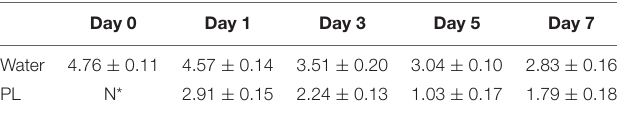
TABLE 4 | Total BALOs counts of BD group in water (log PFU mL − 1 ) and PL shrimp (log PFU mg − 1 ).